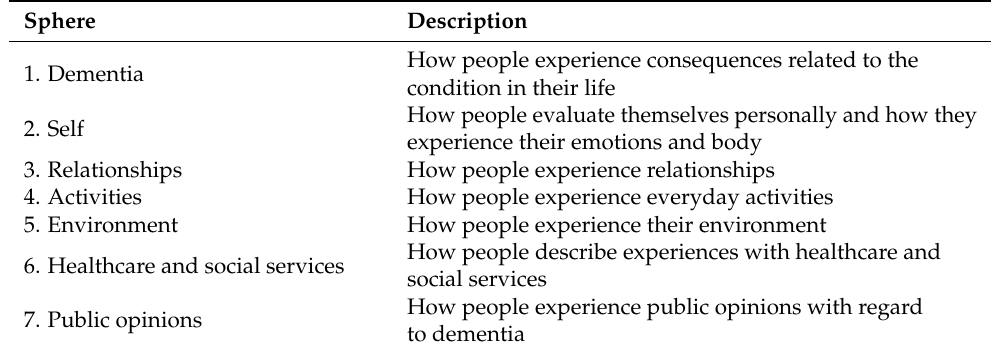
Table 4. Description of the seven spheres of everyday life.